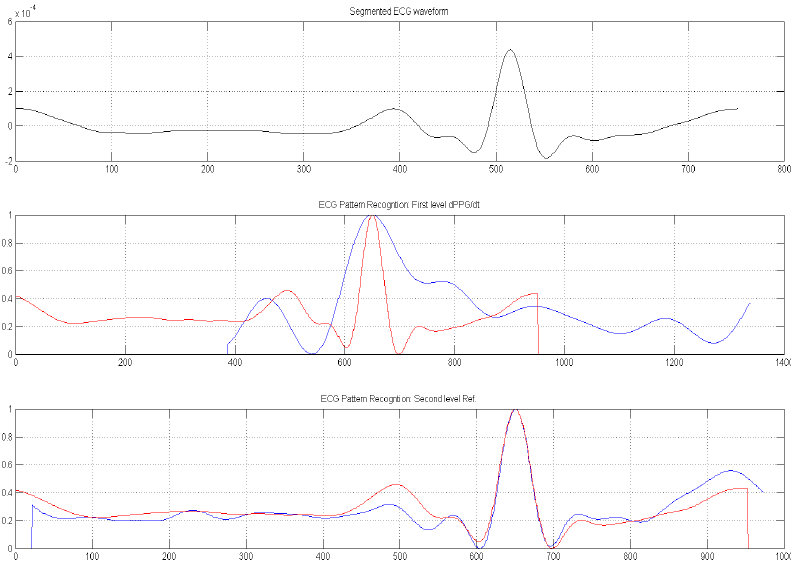
Figure 18. The ECG Patter Recognition GUI: First window shows the segmented ECG waveform according to segmented PPG onset (t k ); The second ones reports segmented ECG (red) and first derivative of corresponding PPG waveform (dPPG/dt—blue) while the third window reports graphical representation of the segmented ECG (red) and reference ECG pattern (blue). Both waveforms plotted in second and third windows will be used for sample cross correlation analysis as previous described in Equations (3) and (4).